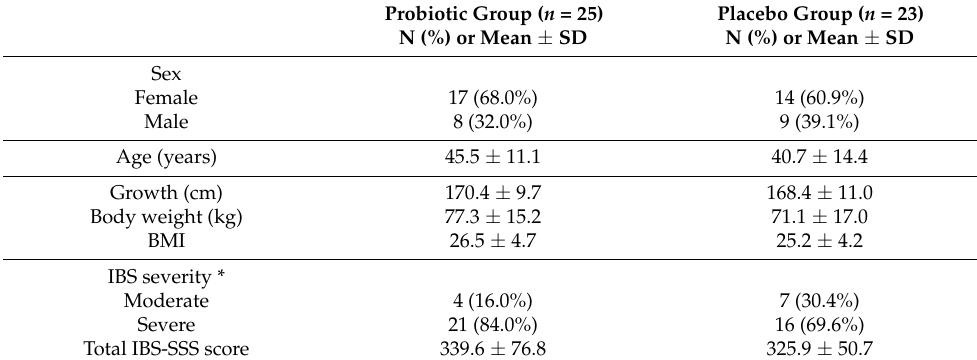
Table 2. Patient characteristics.